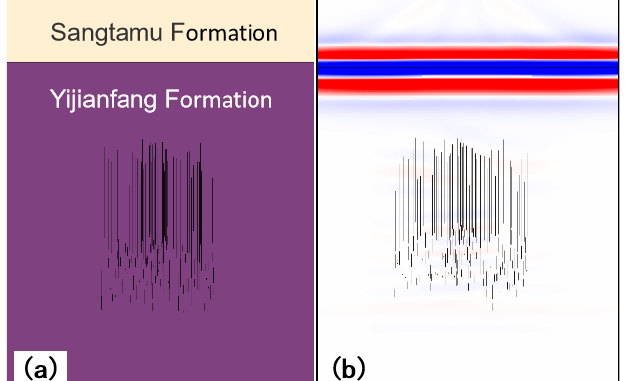
Figure 8. A geological model and forward modeling section of the fractured reservoir. The black lines are fractures and are designed as an aggregate. The single fracture width is less than 1 m and the height is 200 m. ( a ) the fracture geologic model; ( b ) the profile of fracture model superimposed on forward simulation results.